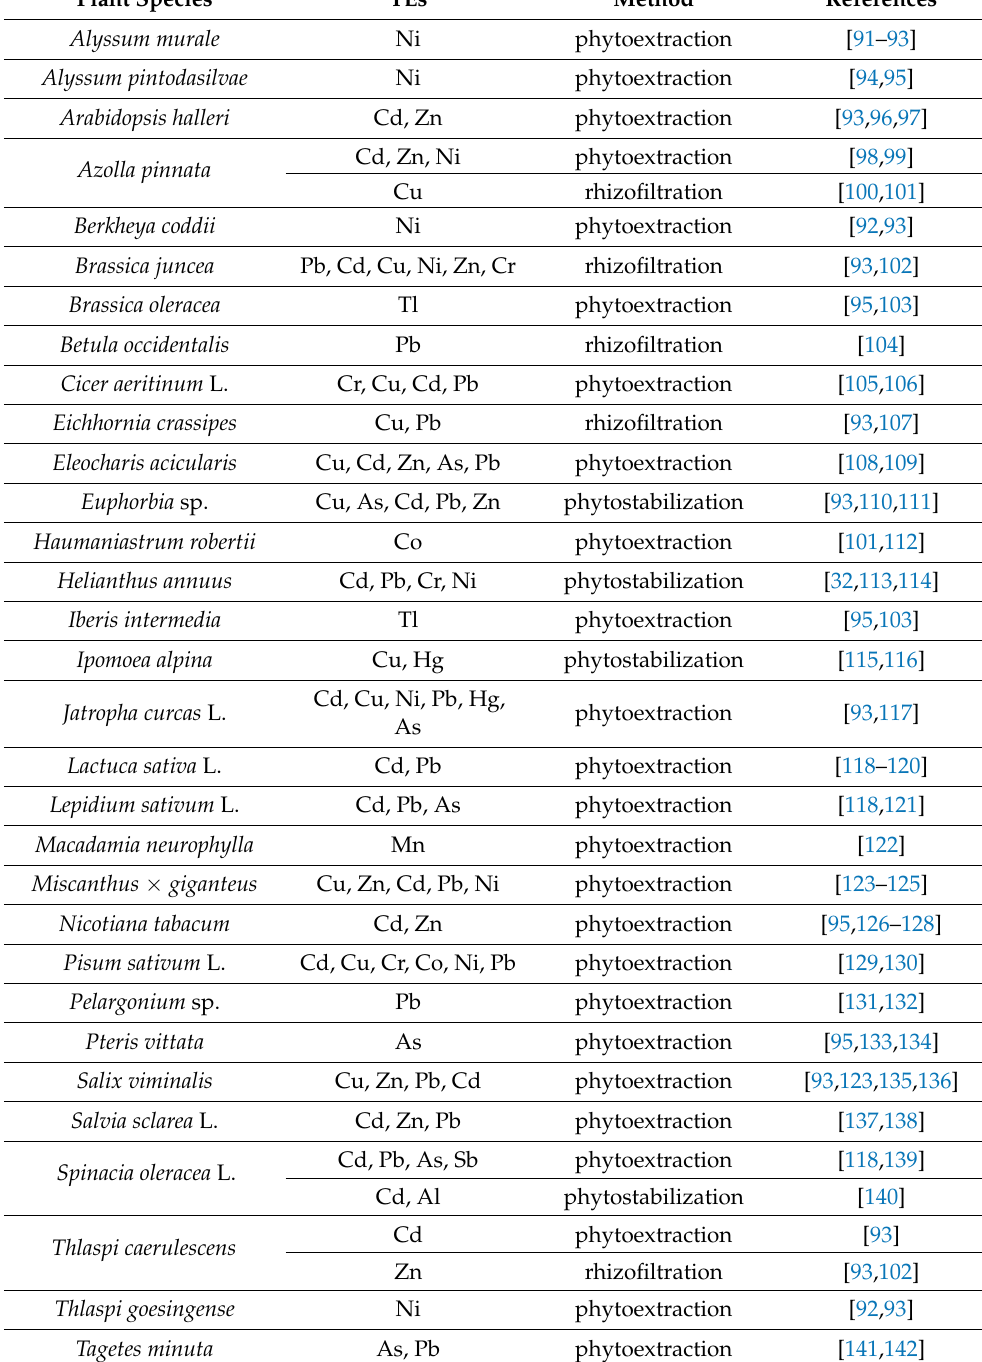
Table 1. Examples of hyperaccumulators and recommended phytoremediation